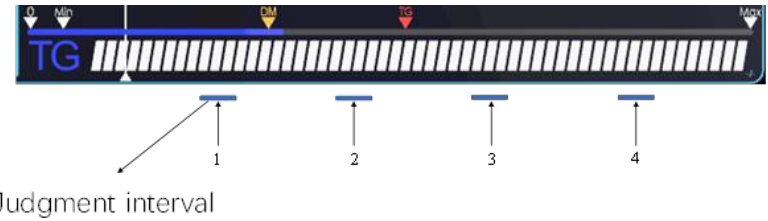
Figure 5. Time response point interval of single channel.